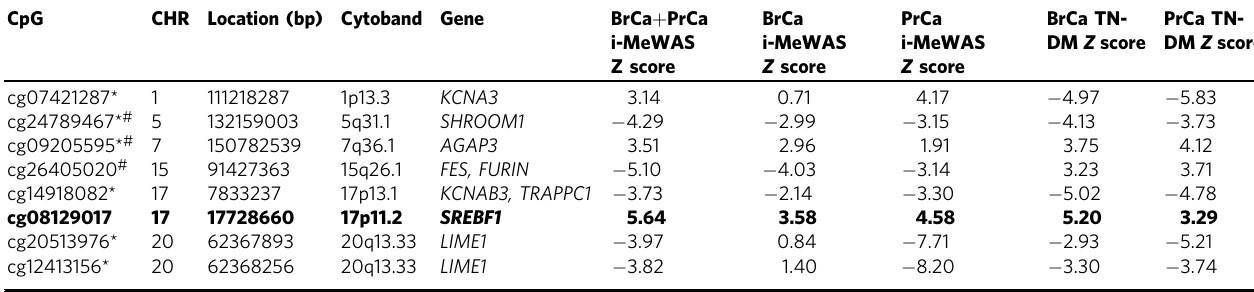
BrCa breast cancer, PrCa prostate cancer, i-MeWAS imputation-based methylome-wide association study, TN-DM tumour vs normal tissue adjacent to tumour differential methylation. *and # indicate that the CpGs that were not signi fi cantly differentially methylated in BrCa i-MeWAS analysis (FDR>0.05) PrCa i-MeWAS analysis (FDR>0.05), respectively. The row in bold font indicates the common DM CpG between the eight DM CpGs identi fi ed through the overlap analysis using BrCa + PrCa meta-analysed GWAS-SS (Fig. 4a) and the one DM CpG identi fi ed through the overlap analysis of individual GWAS-SS (Fig. 4b).